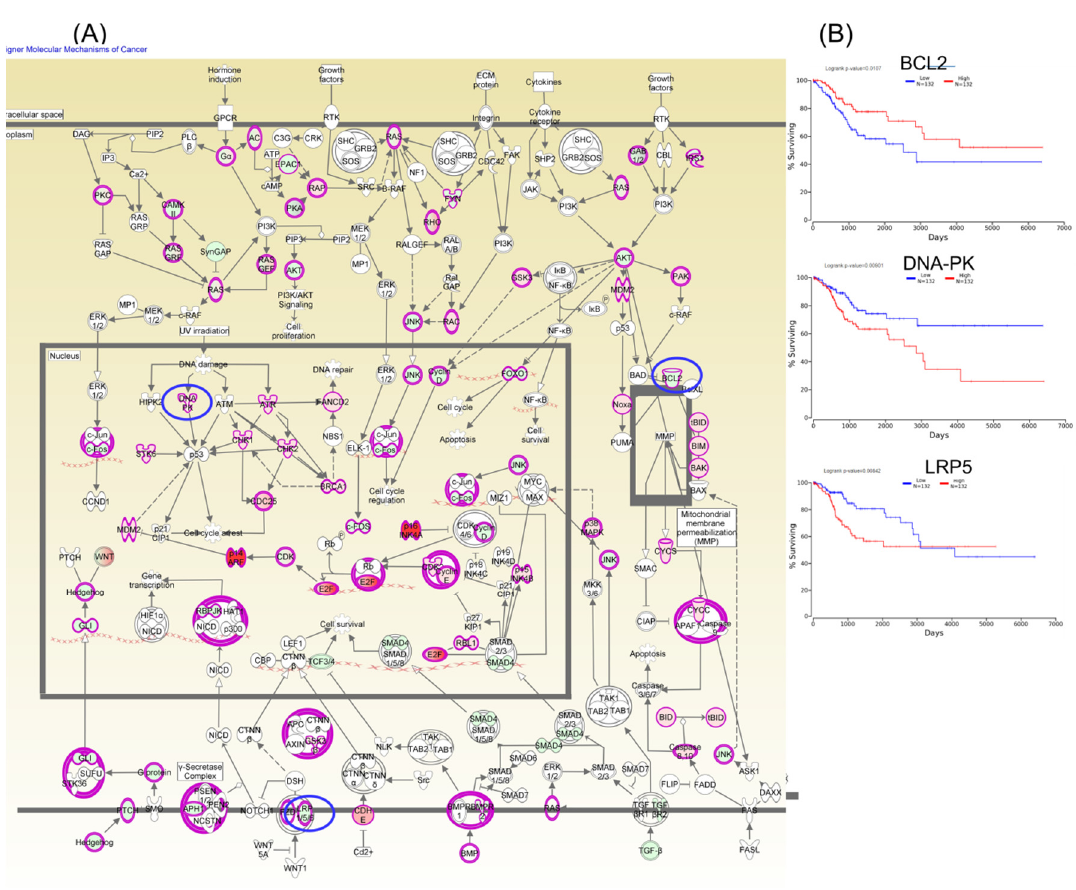
Figure 6. A molecular mechanism for cancer pathogenesis based on altered genes in CC (Panel A ), wherein the key genes BCL2, DNA-PK, and LRP5 predict overall survival rate (Panel B ); red: overexpressed genes, green: downregulated genes, blue circles are for genes predicting overall survial rate in CC